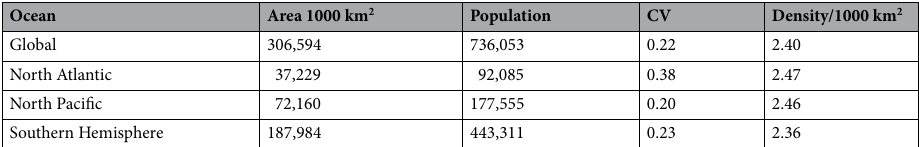
Table 2. Population and density estimates for sperm whales in different ocean areas in 1993, extrapolating from survey data using weighted stepwise regression of survey densities on oceanographic variables. The equator is a latitudinal boundary of the ocean areas.